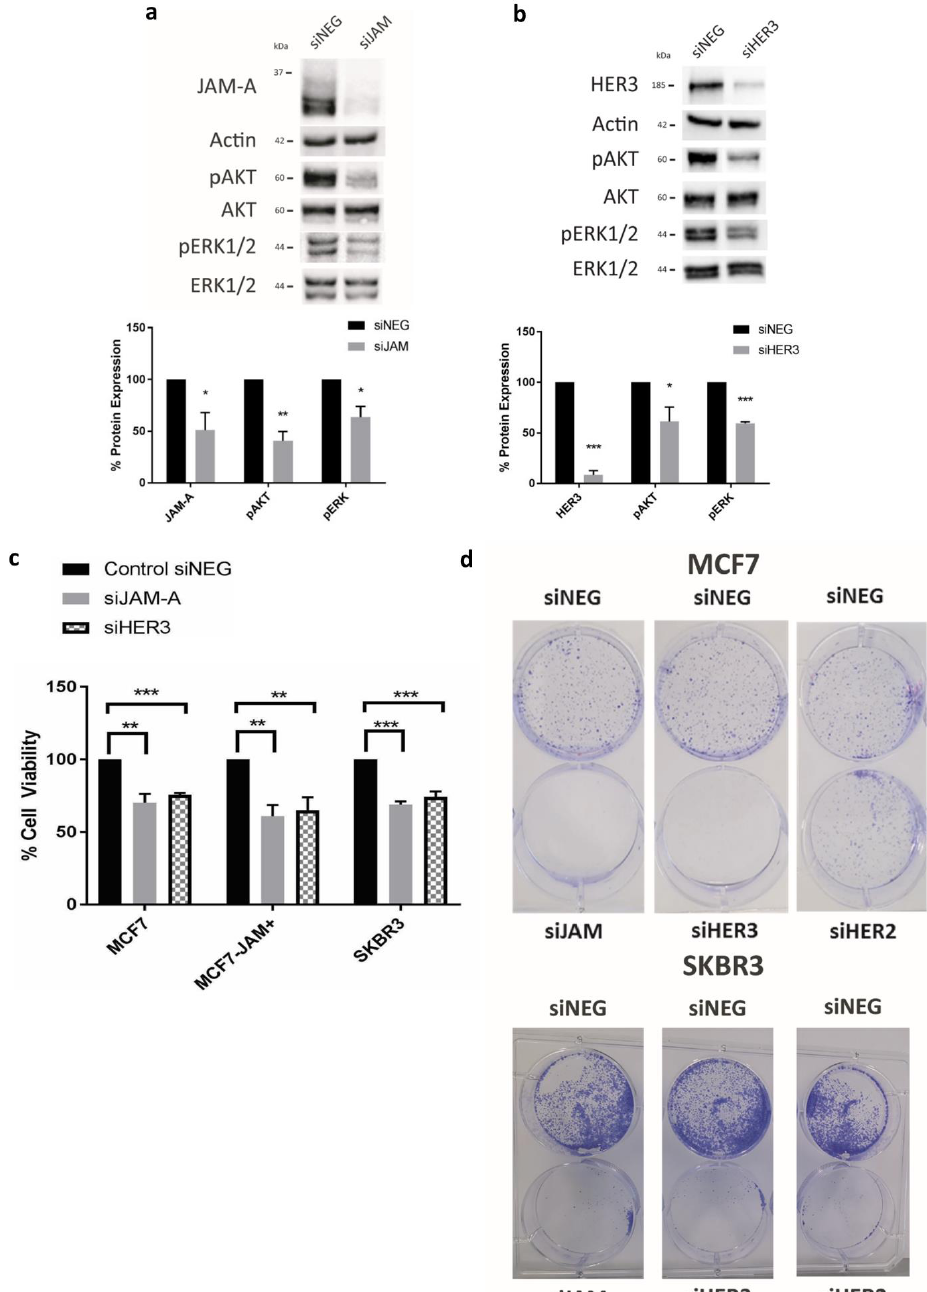
Figure 2. Silencing of JAM-A or HER3 reduces activation of AKT/ERK, cell viability and colony formation. Breast cancer cells were transfected with 25nM control siRNA (siNEG) or a pool of siRNA targeting JAM-A, HER3 or HER2 and harvested at 72 h for immunoblotting or used in functional assays. Representative western blot image and densitometric analysis for pAKT protein expression normalized to AKT expression, pERK expression normalized to ERK expression and JAM-A normalized to actin expression in SK-BR-3 after ( a ) JAM-A knockdown and ( b ) HER3 knockdown. ( c ) Cell viability measured by MTT assay in control MCF7 cells overexpressing empty vector (MCF7), MCF7 cells overexpressing JAM-A (MCF7-JAM+) and SKBR-3 breast cancer cell lines after 72h of knockdown showing reduction in proliferation in all cell lines after JAM-A or HER3 knockdown. ( d ) Colony formation assay at day 9 revealing that JAM-A and HER3 knockdown completely inhibited colony formation of MCF7 and SKBR3 cells compared to siNEG control, while HER2 knockdown only affected colony formation in HER2-positive SKBR3 cells. Experiments were performed three times and data represent mean ± s.e.m, compared using two-tailed, equal variance Student’s t -tests, * p < 0,05, ** p < 0.01, *** p <